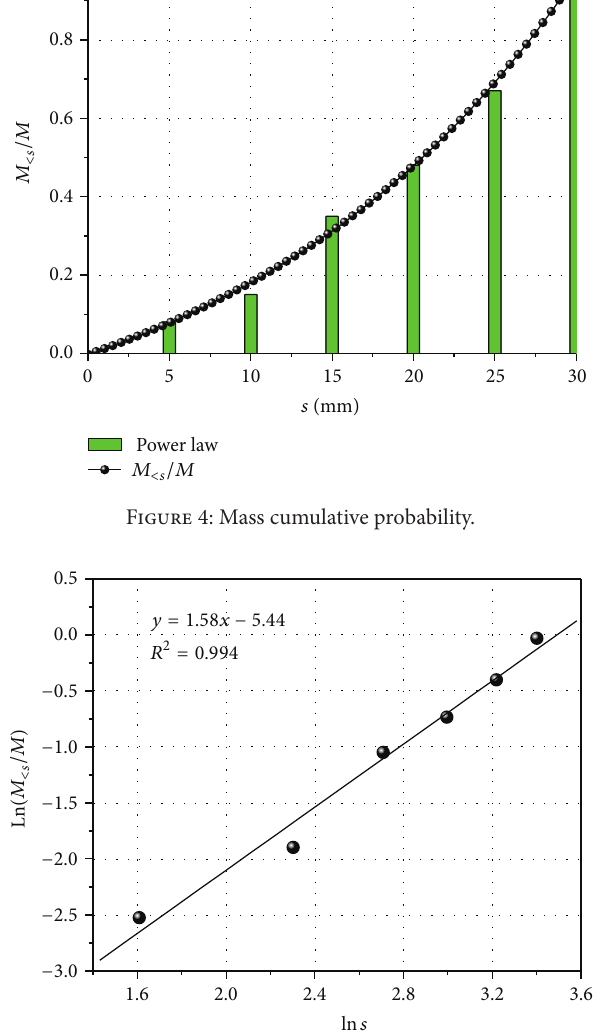
Figure 5: Fractal dimension of size distribution.